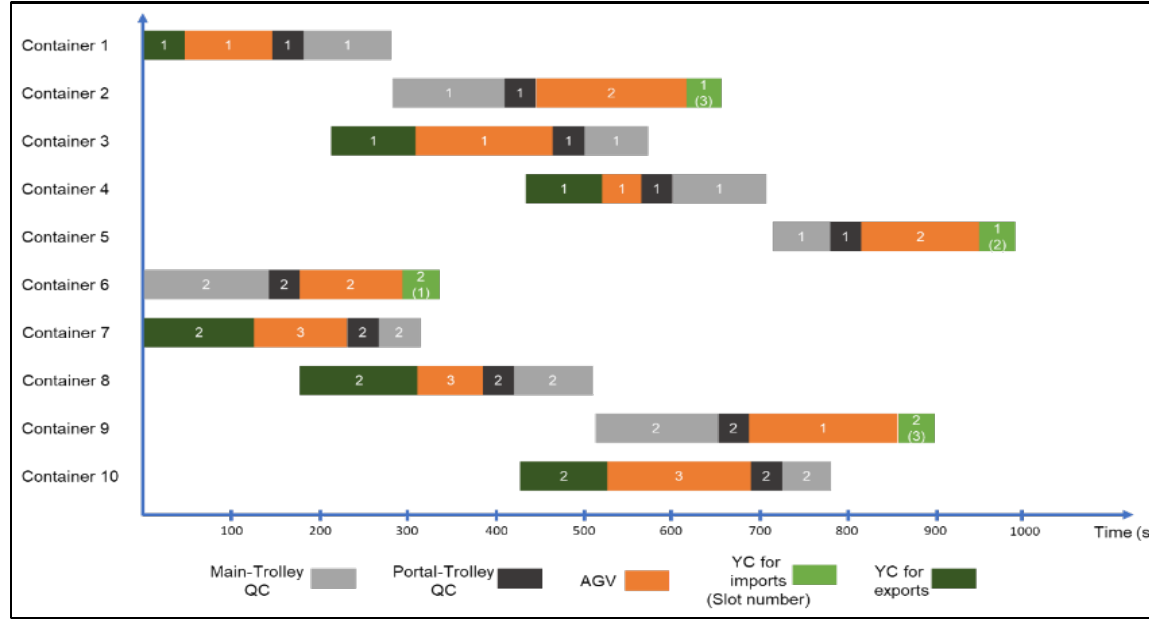
Figure 4. Gantt chart for all equipment used .